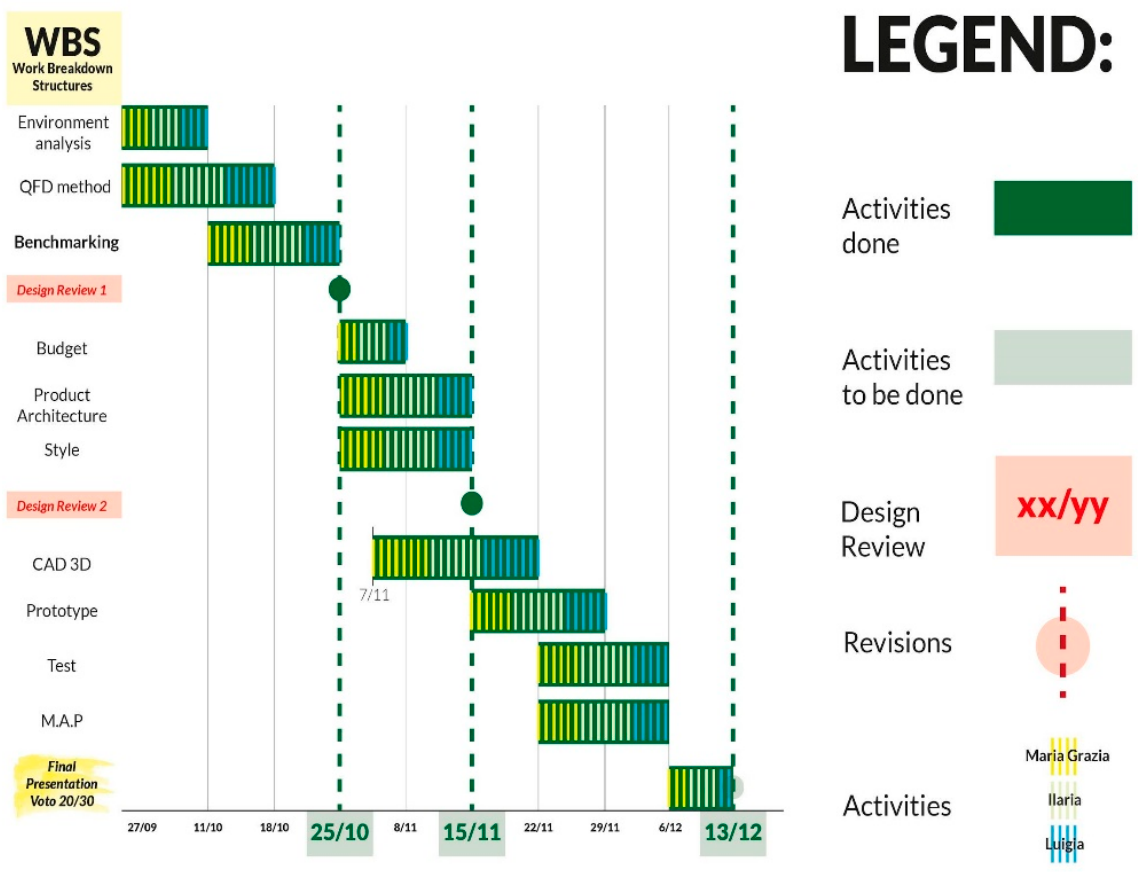
Figure 3. Gantt Plan.